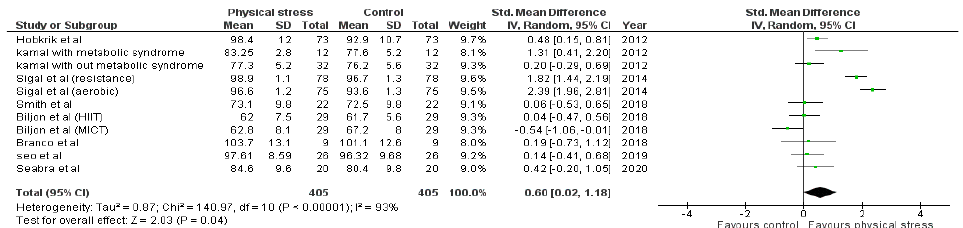
Figure 9. Forest plot showing the results for waist circumference.